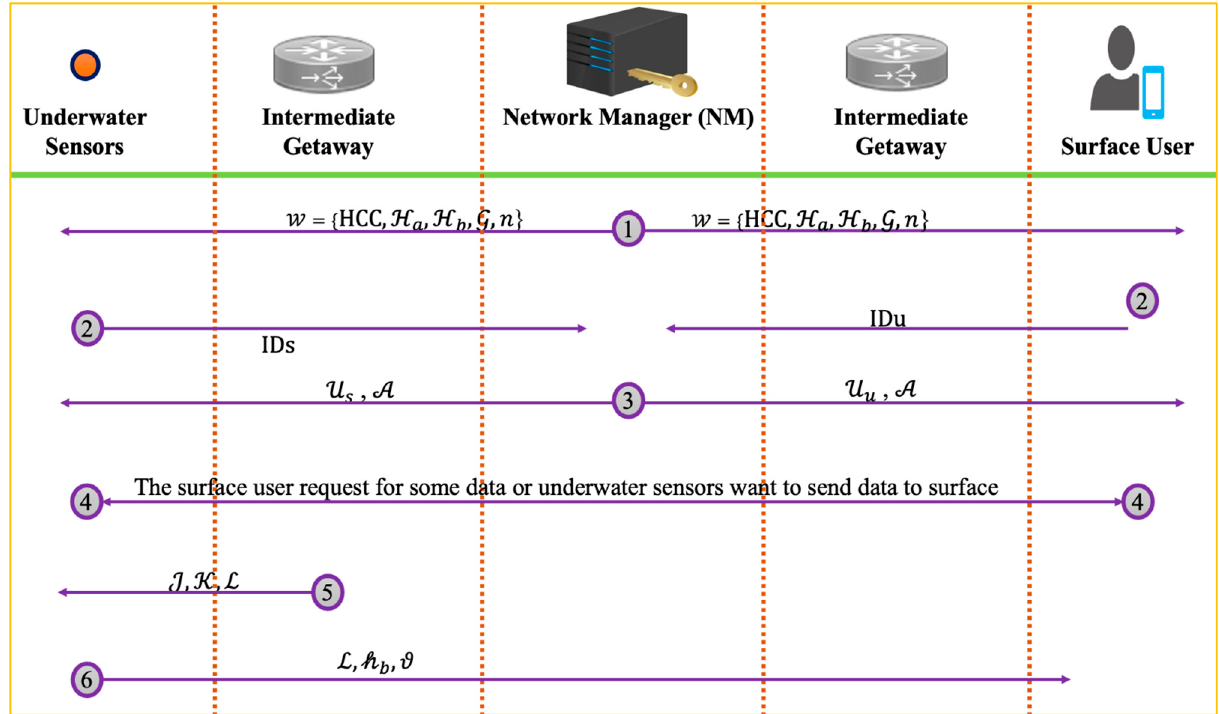
Figure 4. Deployment of the proposed